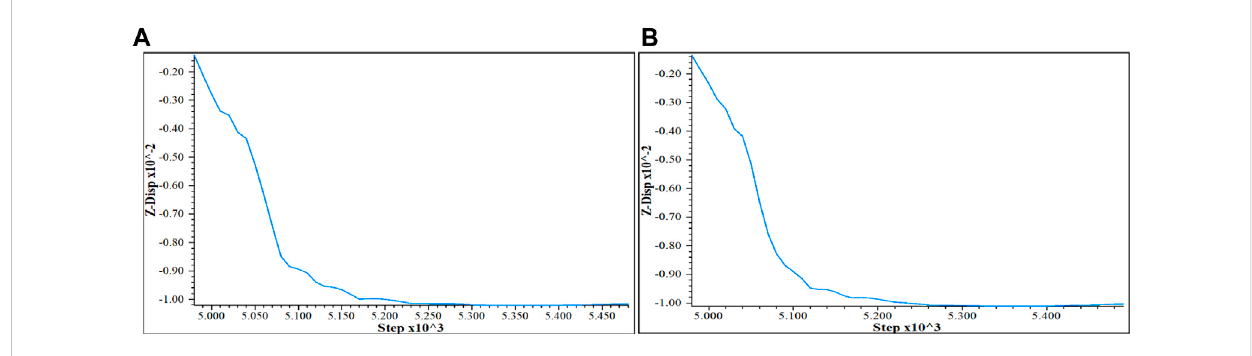
FIGURE 10 Vertical displacement curve when the uniaxial compressive strength changes. (A) Vertical displacement curve when the uniaxial compressive strength is 36.7 MPa (with support) (B) Vertical displacement curve when the uniaxial compressive strength is 231.7 MPa (with support).